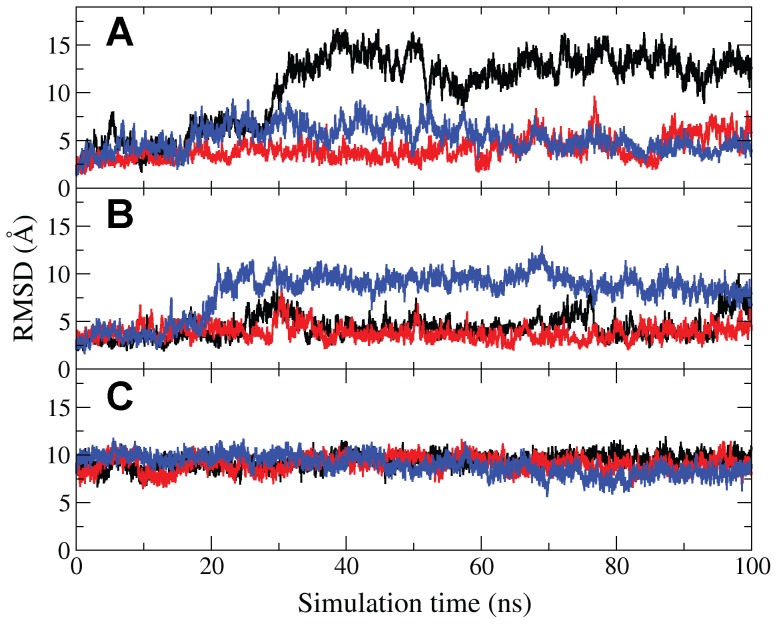
Plots of RMSD relative to the [Fe3S4]+
(open, substrate-free) crystal structure over the course of 3×100 ns aMD simulations of (A) [Fe4S4]2+
(open,substrate-free), (B) [Fe4S4]2+/HMBPP(open,docked), and (C) [Fe4S4]2+/HMBPP(closed) IspH.